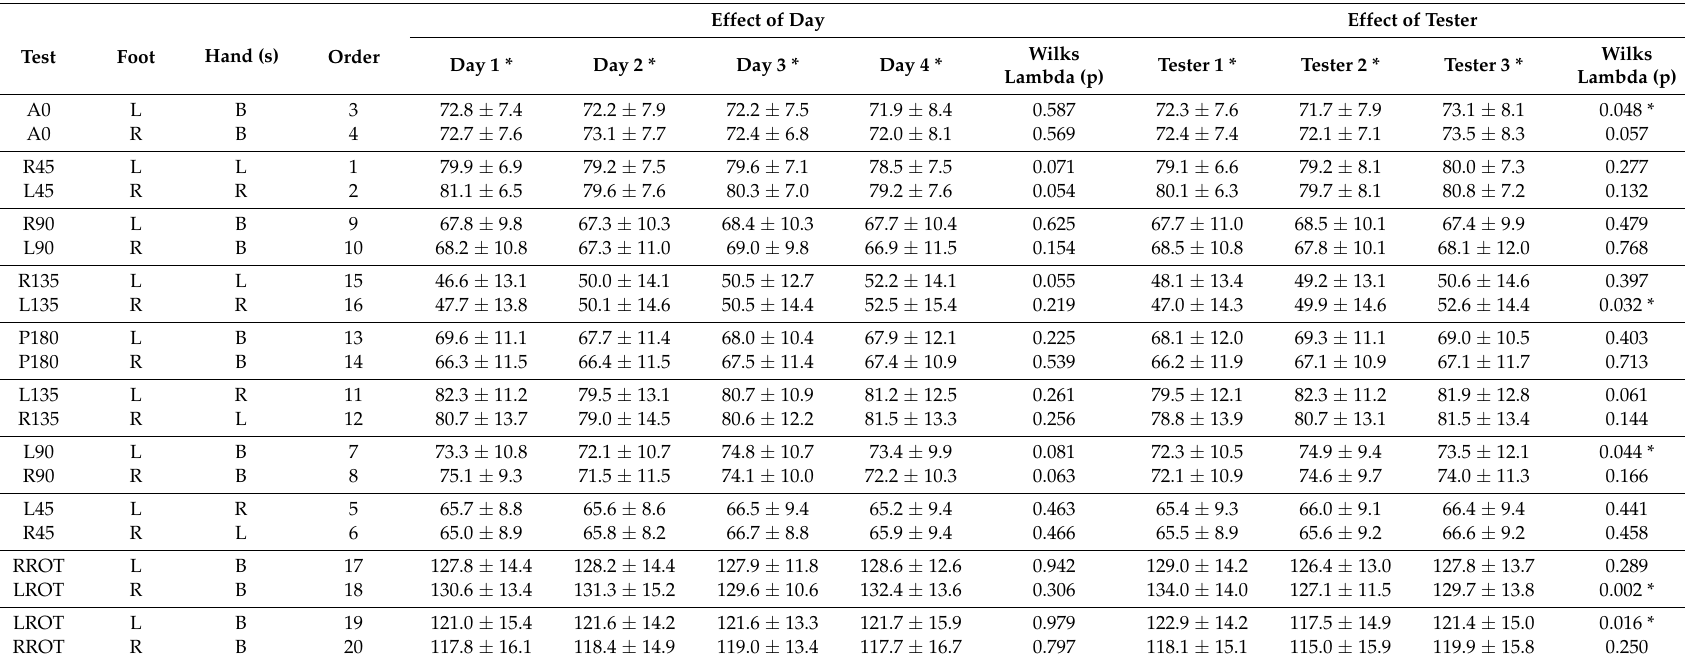
Table 2. Effect of day and tester on HSEBT